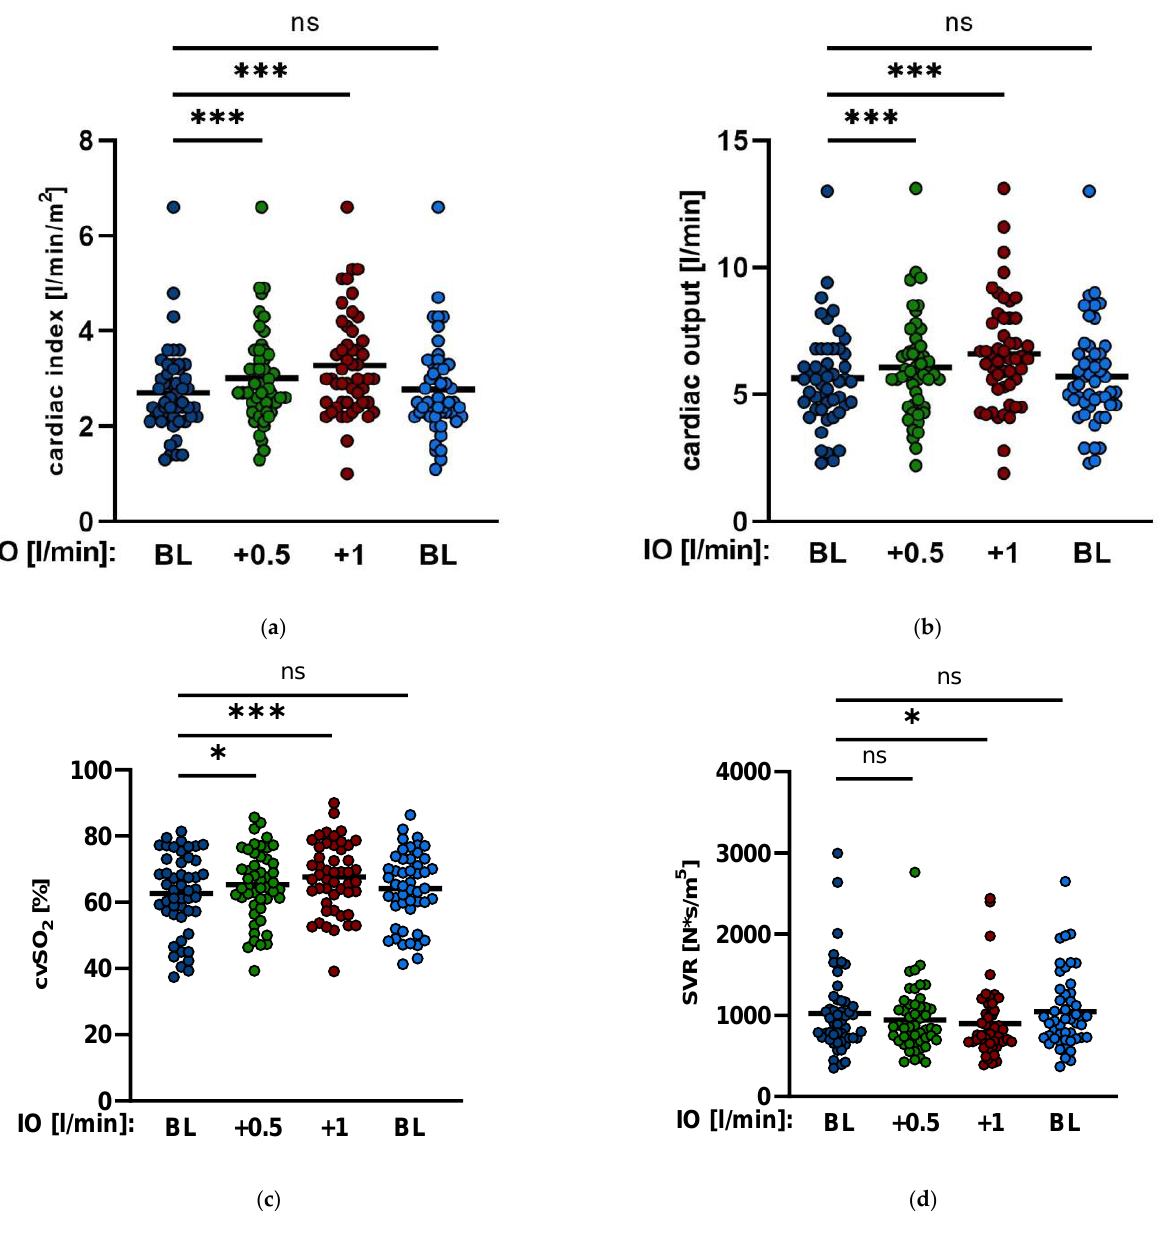
Figure 4. Hemodynamic changes by Impella ® output. ( a , b ). Cardiac index (CI) and cardiac output (CO) during different changes of Impella support. ( c , d ). Central venous oxygen saturation (cvsO 2 ) and systemic vascular resistance (SVR) after enhancing Impella ® output by mean of 0.5 L/min and mean of 1.0 L/min (IO: Impella output; BL: baseline; ns: not significant, p ≥ 0.05; *: p < 0.05; ***: p < 0.001).